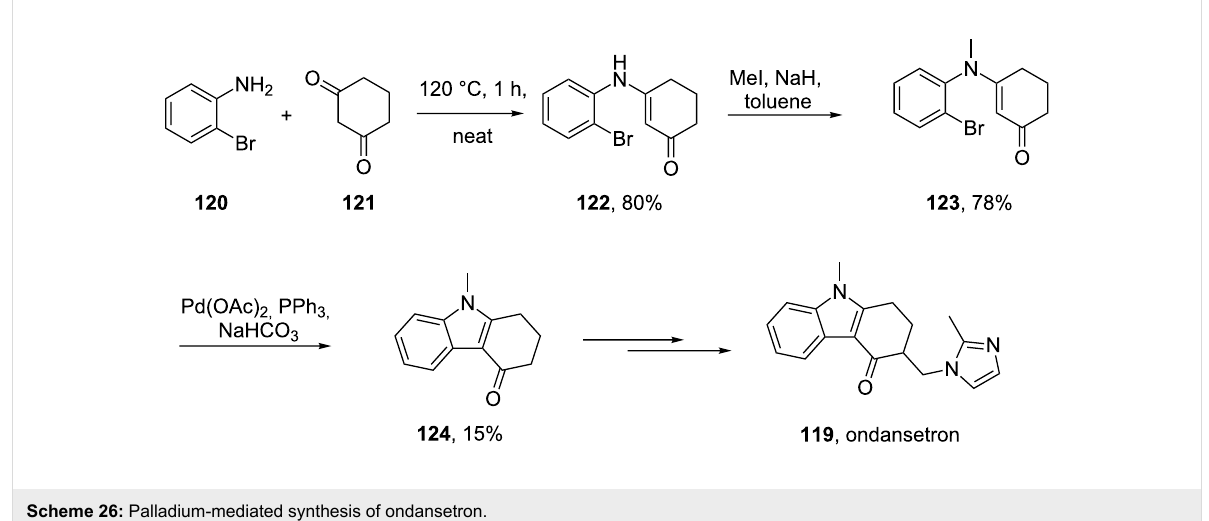
Scheme 26: Palladium-mediated synthesis of ondansetron.